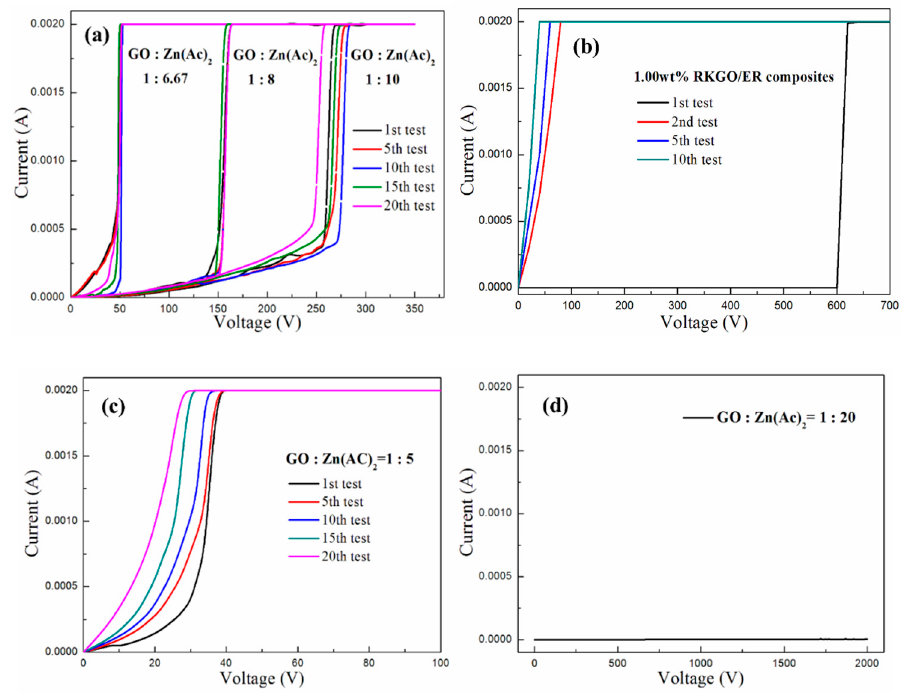
Figure 9. I-V characteristics of ( a ) the specimens with 1:10, 1:8, and 1:6.67 weight ratios of GO to Zn(Ac) 2 , ( b ) the specimen of pure GNPs / ER, ( c ) the specimens with 1:5 weight ratios of GO to Zn(Ac) 2 , and ( d ) the specimens with 1:20 weight ratios of GO to Zn(Ac) 2 .